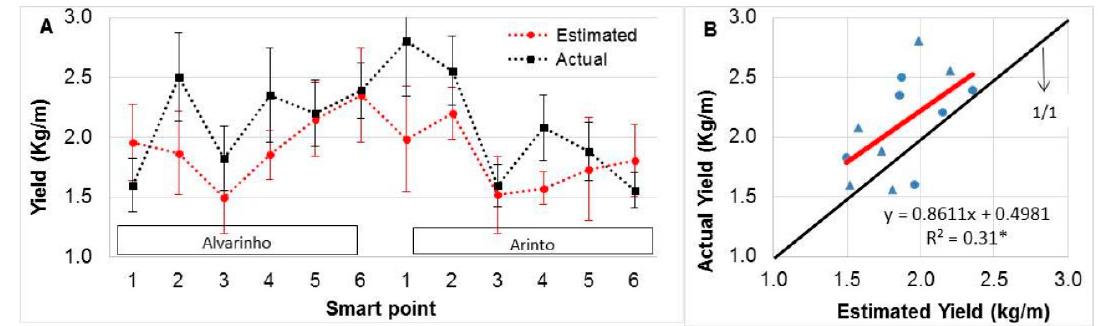
Figure 6. Block diagram of feature extractor service architecture.